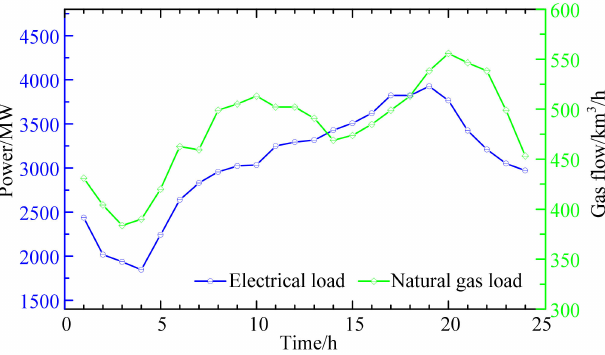
Figure A2. Electric load and natural gas load of